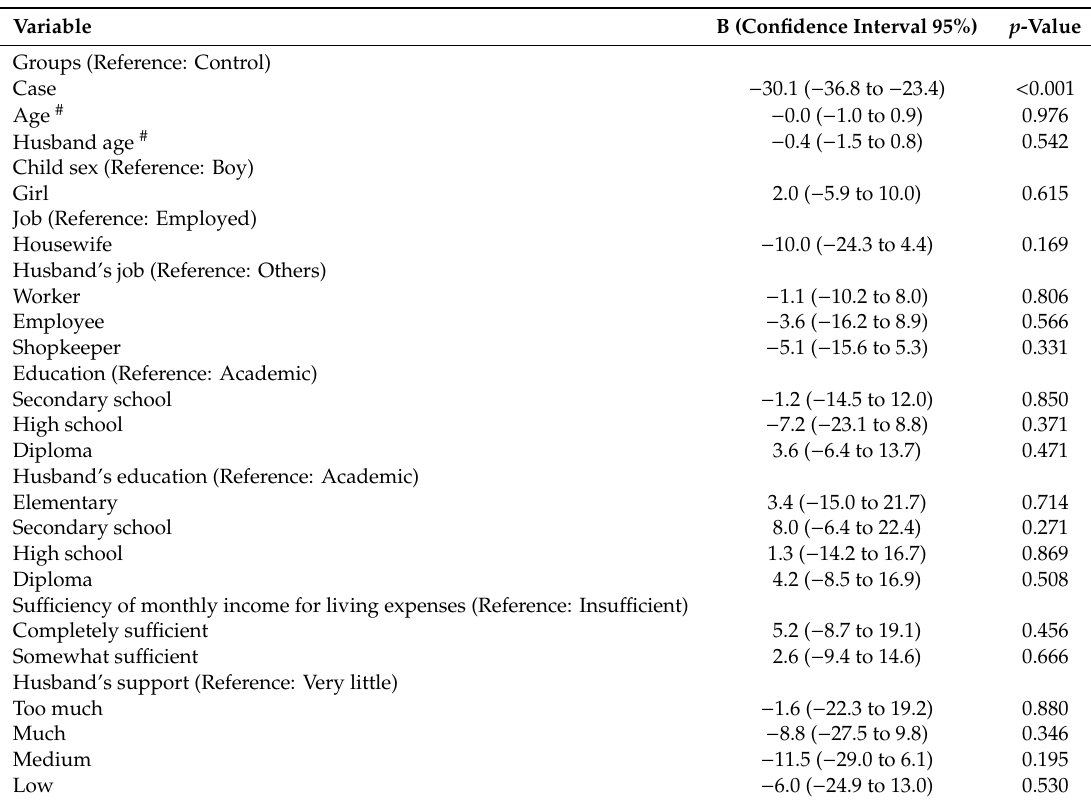
Table 4. The relationship between maternal functioning and depression based on general linear model ( n =